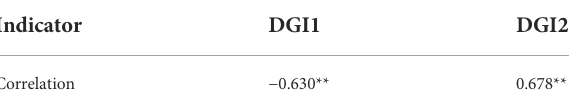
TABLE 3 Correlation between the dry weight of the combustible matter and the subsoil index derived from the Sentinel-2 remote- sensing data.